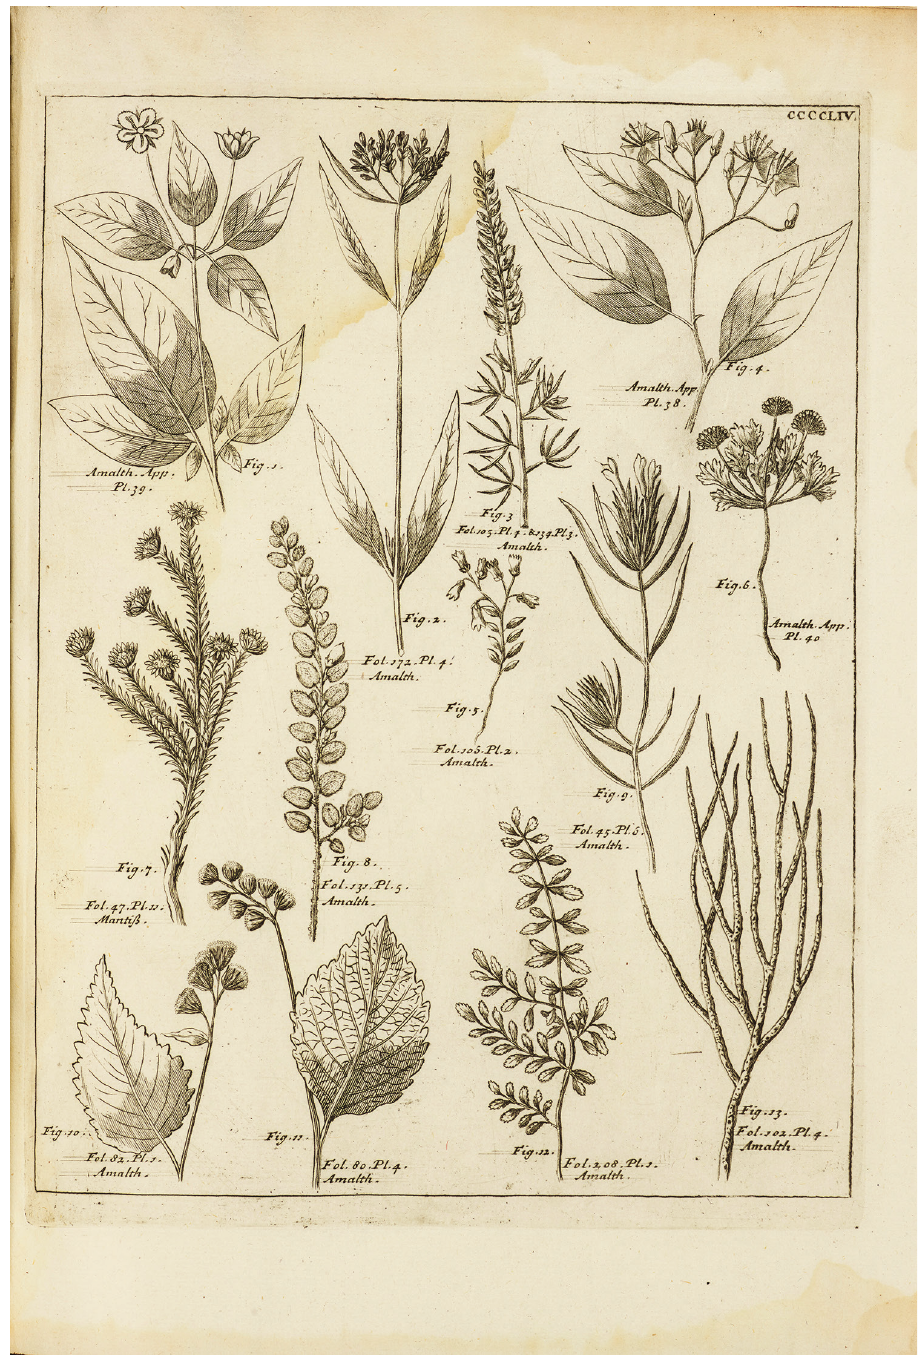
Figure 1. Plukenet, L. 1705. Amaltheum botanicum tab. 454, f.